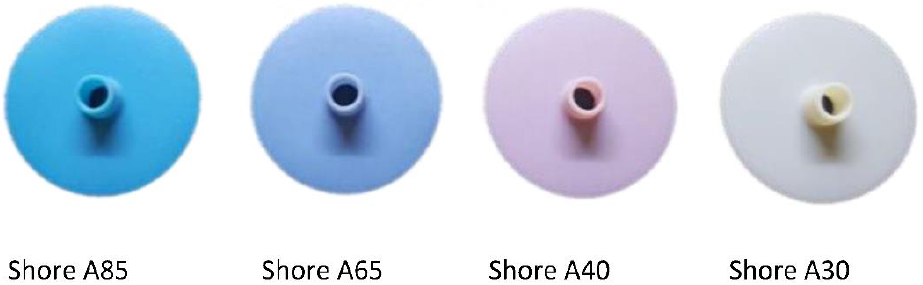
Figure 6. Valves fabricated with different combinations of two base materials to achieve different levels of hardness.